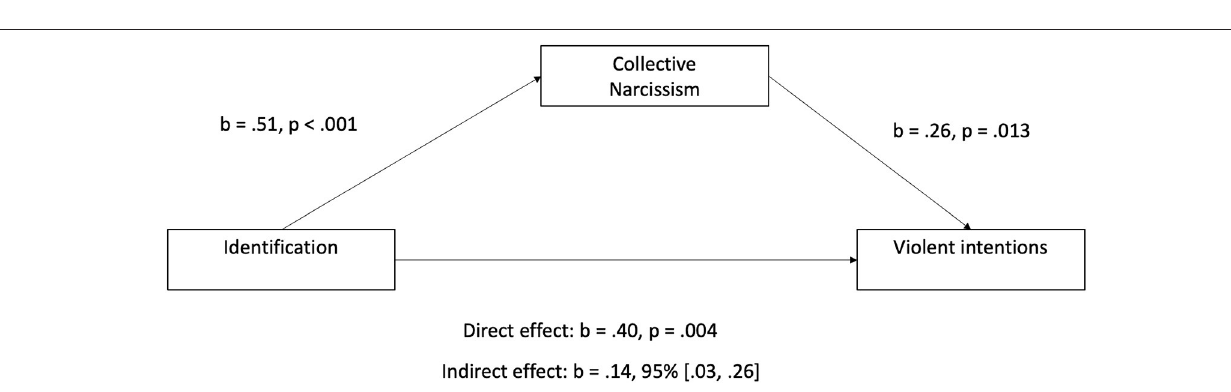
FIGURE 2 | Mediation model of how collective narcissism partially mediates the association between identification and violent intentions amongst soccer supporters. Estimates are non-standardised estimates. Standardised estimates are presented in the